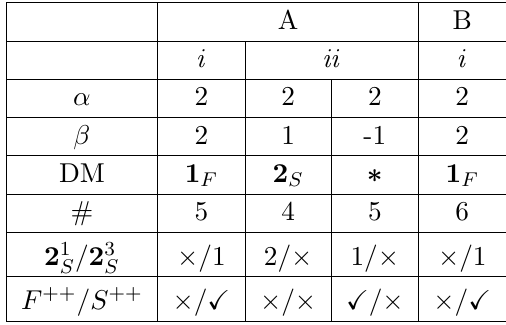
Table 4. The same as in table 2 for diagram 1.c of (cid:12)gure